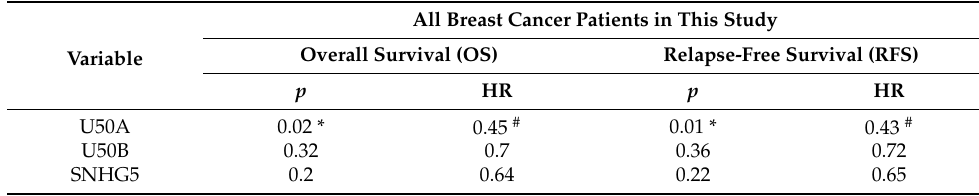
Table 2. Survival analysis of U50A, U50B, and SNHG5 in breast cancer patients.